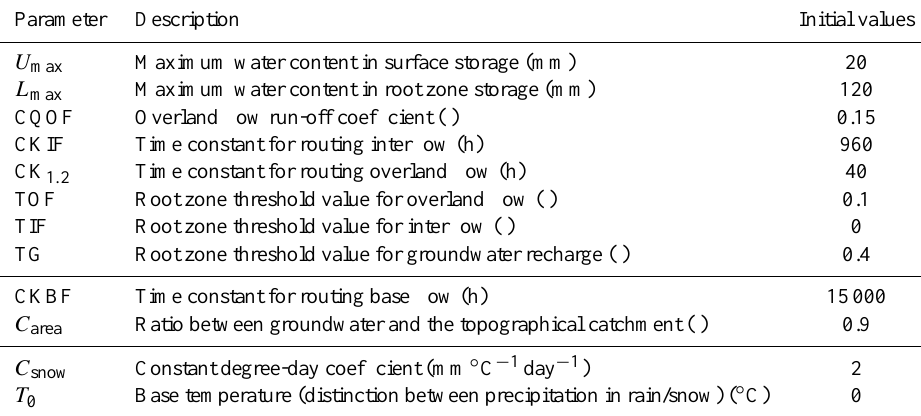
Table 3. Initial parameter values used for the NAM